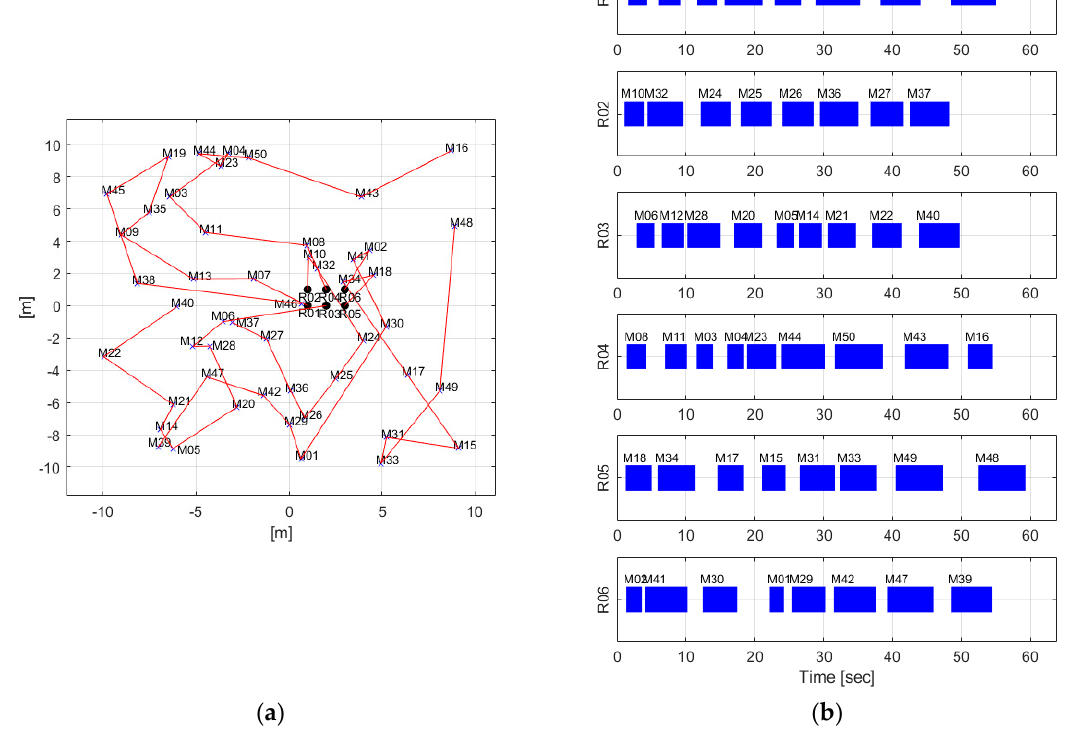
Figure 8. The results for huge case using TACTAR: ( a ) 2D situation map; ( b ) timetable.